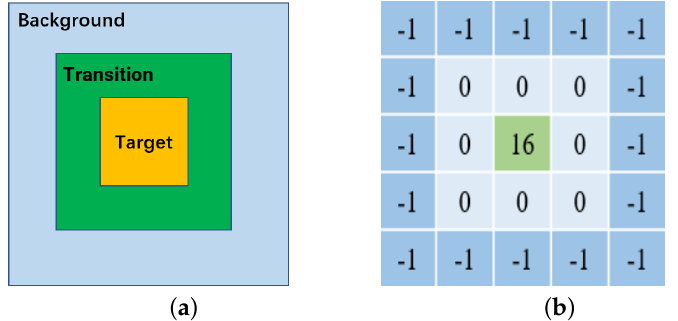
Figure 3. The hierarchical gradient model and the Laplacian filter kernel; ( a ) is the hierarchical gradient model, and ( b ) is the Laplacian filter kernel.